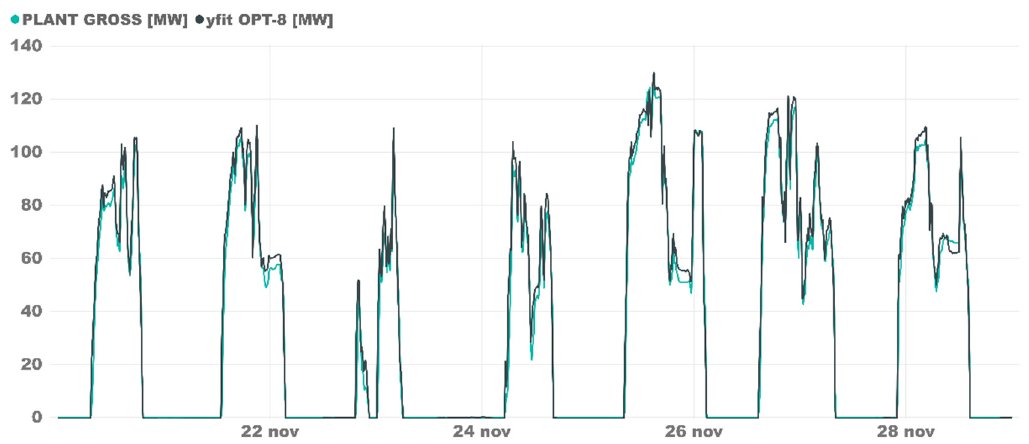
Figure 7. OPT-8 Plant B model validation in a continuous operation week.